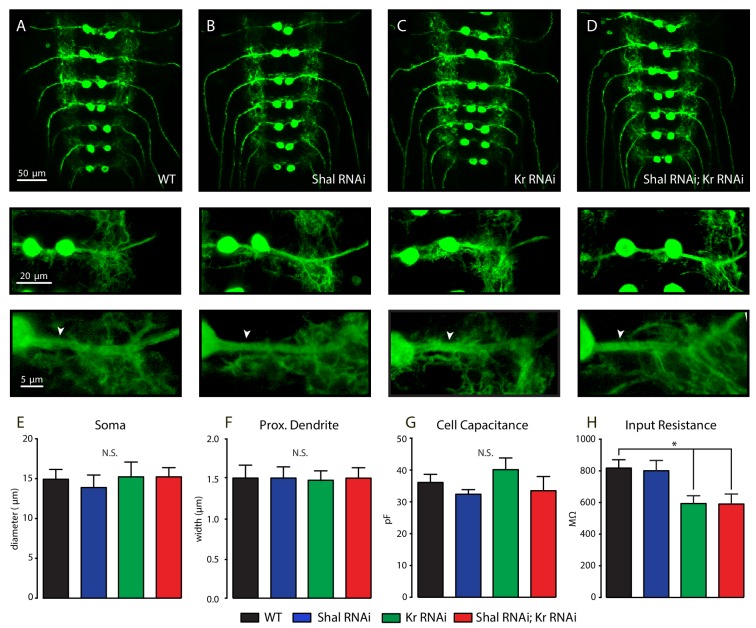
Normal motoneuron morphology.(A–D) Confocal max projections of MN1-Ib motorneurons (MN1-GAL4 > UAS-CD8:GFP) in WT (A), Shal-RNAi (B), Krüppel (Kr)-RNAi, (C) and combined Shal and Krüppel-RNAi (Shal-RNAi; Kr-RNAi, (D). Representative MN1-Ibs shown at higher magnification in inserts to reveal single neuron morphology. Arrows indicate MN1-Ib primary dendrite. (E, F) Quantification of somatic diameter (E) and proximal dendrite width (F) in WT (back), Shal-RNAi (blue), Krüppel-RNAi (Kr, green) and combined Shal and Krüppel-RNAi (Shal-RNAi; Kr-RNAi, red). (G, H) Whole-cell capacitance (G) and input resistance (H) in WT (back), Shal-RNAi (blue), Krüppel-RNAi (Kr, green) and combined Shal-RNAi and Krüppel-RNAi (Shal-RNAi; Kr-RNAi, red). Mean ± S.E.M.; *p<0.05; **p<0.005; ***p<0.0005. N.S., not significant; one-way ANOVA with Bonferoni post-hoc tests.